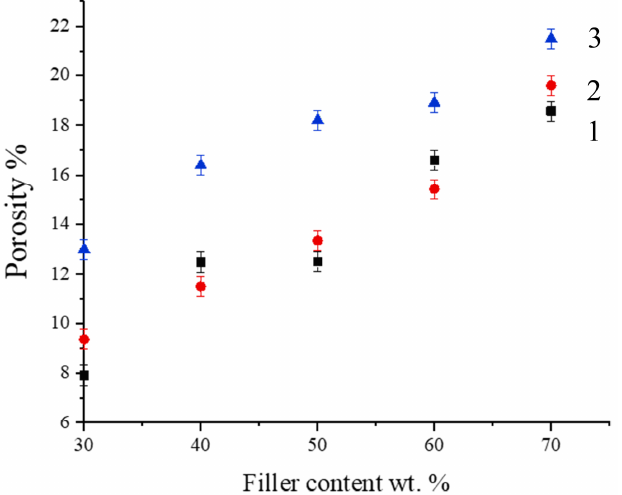
Figure 3. Porosity of PSU based composites filled with NG (1), AG (2) and EG